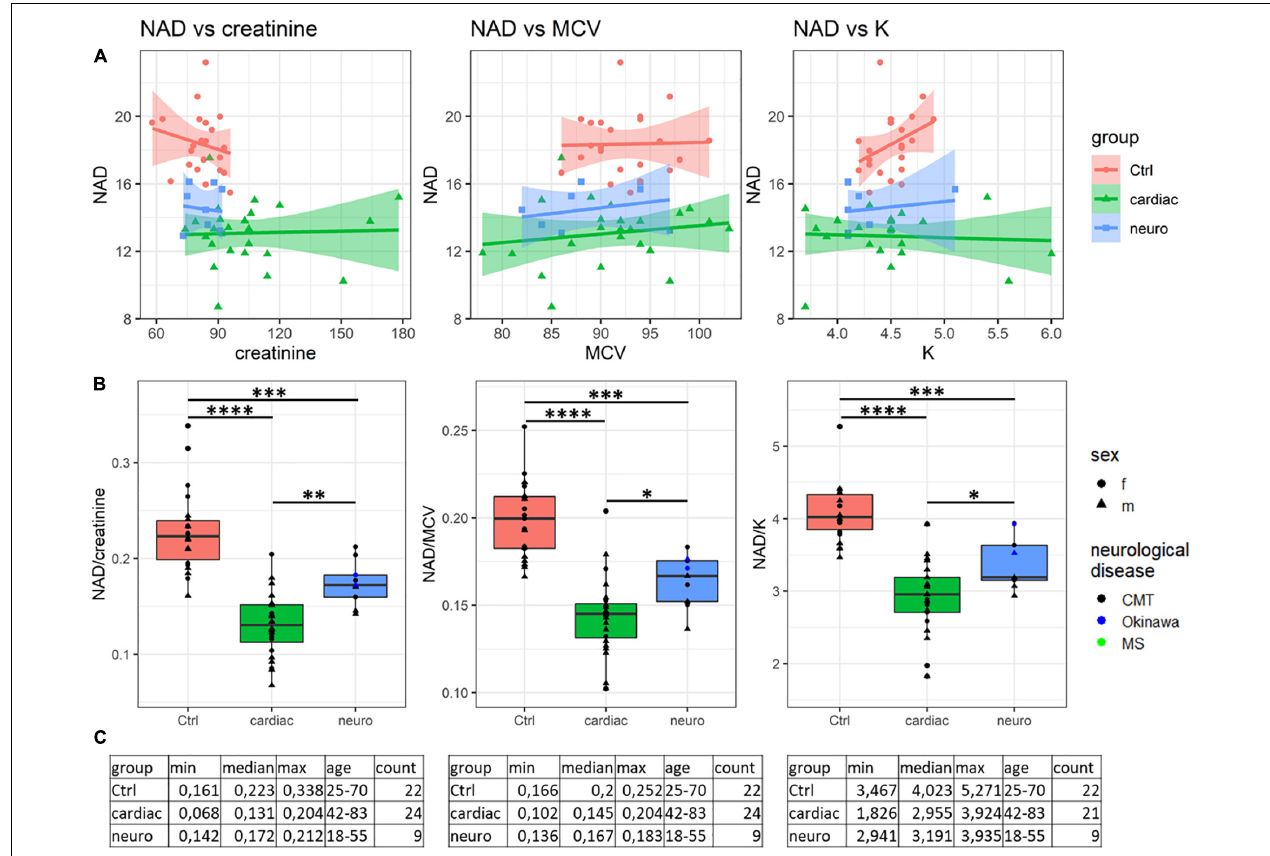
FIGURE 2 | Analysis of discriminating potential of the coupled variations in the NAD + concentrations and other parameters of the blood. (A) Correlations of the NAD + concentrations with the creatinine level, mean corpuscular volume (MCV) and K + ions. (B) Significance of the differences between the NAD + ratios to creatinine, MCV and K + ions, determined for each of the studied samples. (C) Tabular presentation of the ratios used in panel (B) . ∗ p < 0.05, ∗∗ p < 0.01, ∗∗∗ p < 0.001, ∗∗∗∗ p <